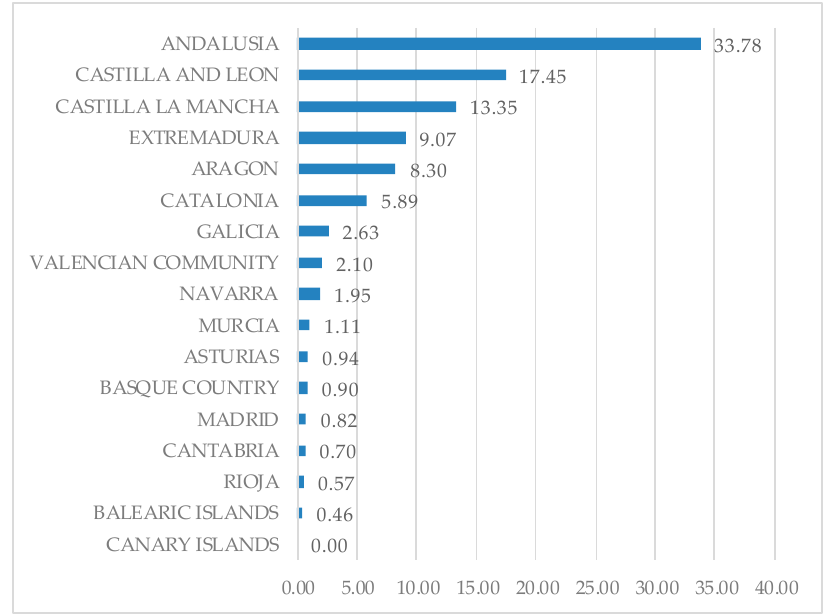
Figure 4. Percentage distribution of the EAGF for the period 2007–2013 (Source: Own elaboration from data published by the Ministry of Agriculture, Fisheries and Food).